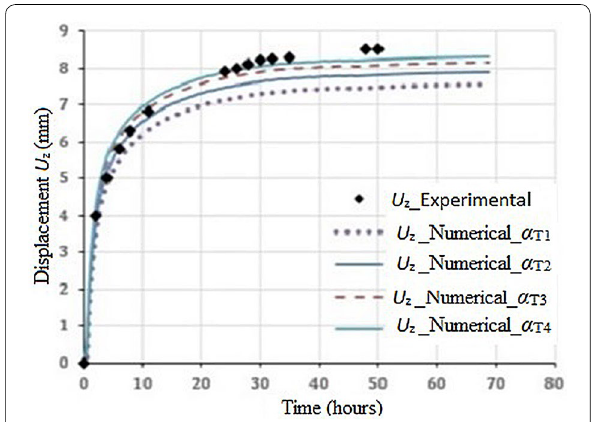
Fig. 11 Evolution of the displacement at the point P 1 of the plywood according to the variation of the tangential shrinkage (scenario 1)